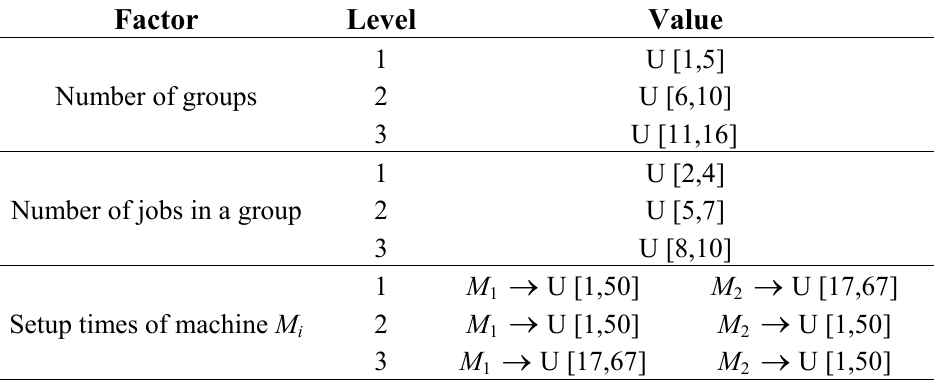
Table 3. Sub-benchmark of instances for the 2-machine FDSGS